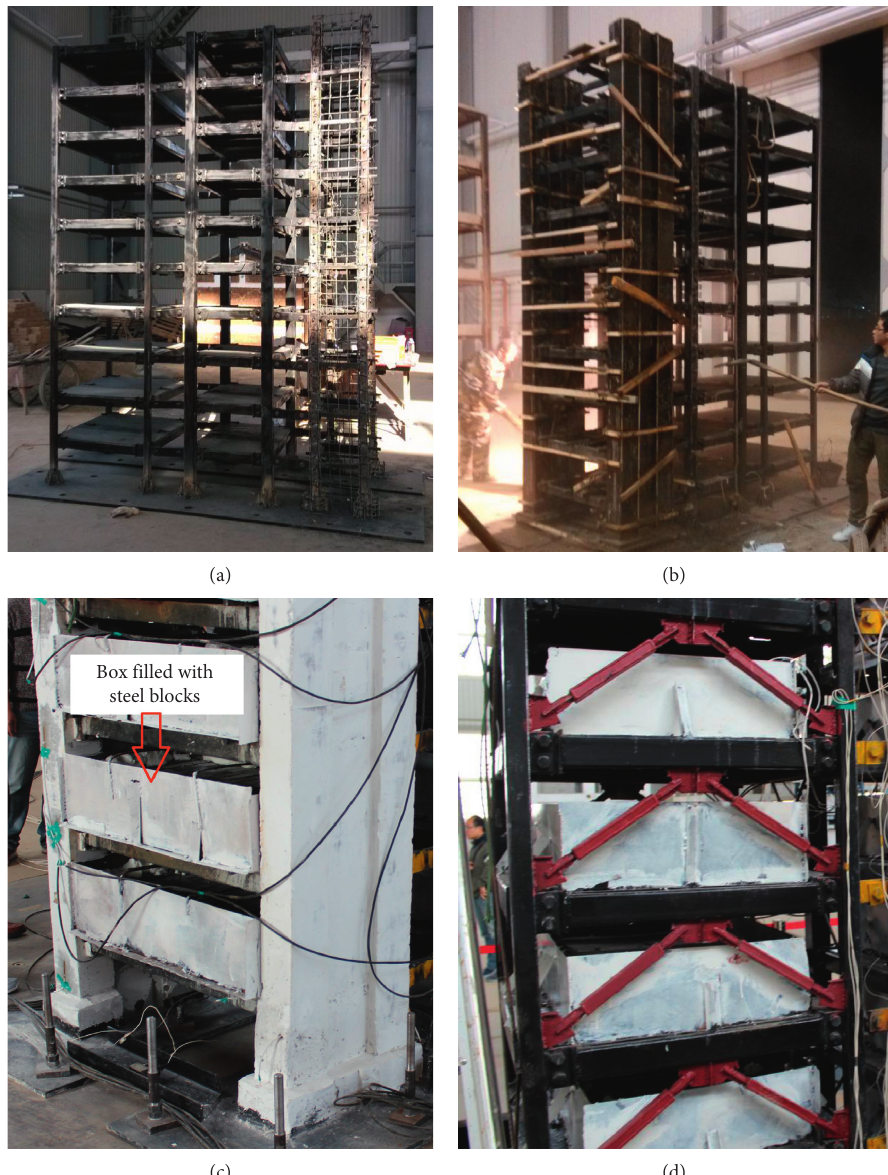
Figure 10: Construction process of the specimen. (a) Construction of the steel frame and wall skeleton. (b) Making the concrete wall. (c) Installation of the additional mass. (d) Installation of the